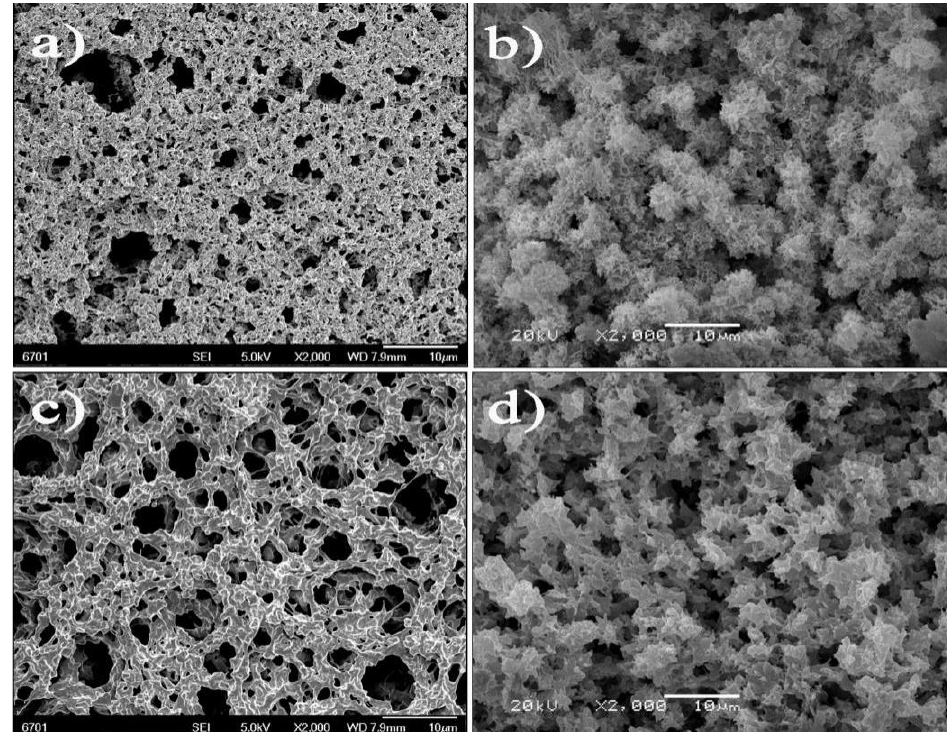
Figure 1. ( a , b ) surface and cross-sectional structure images of the original PVDF membrane. ( c , d ) surface and cross-sectional structure images of the original PVDF membrane after heating treatment.